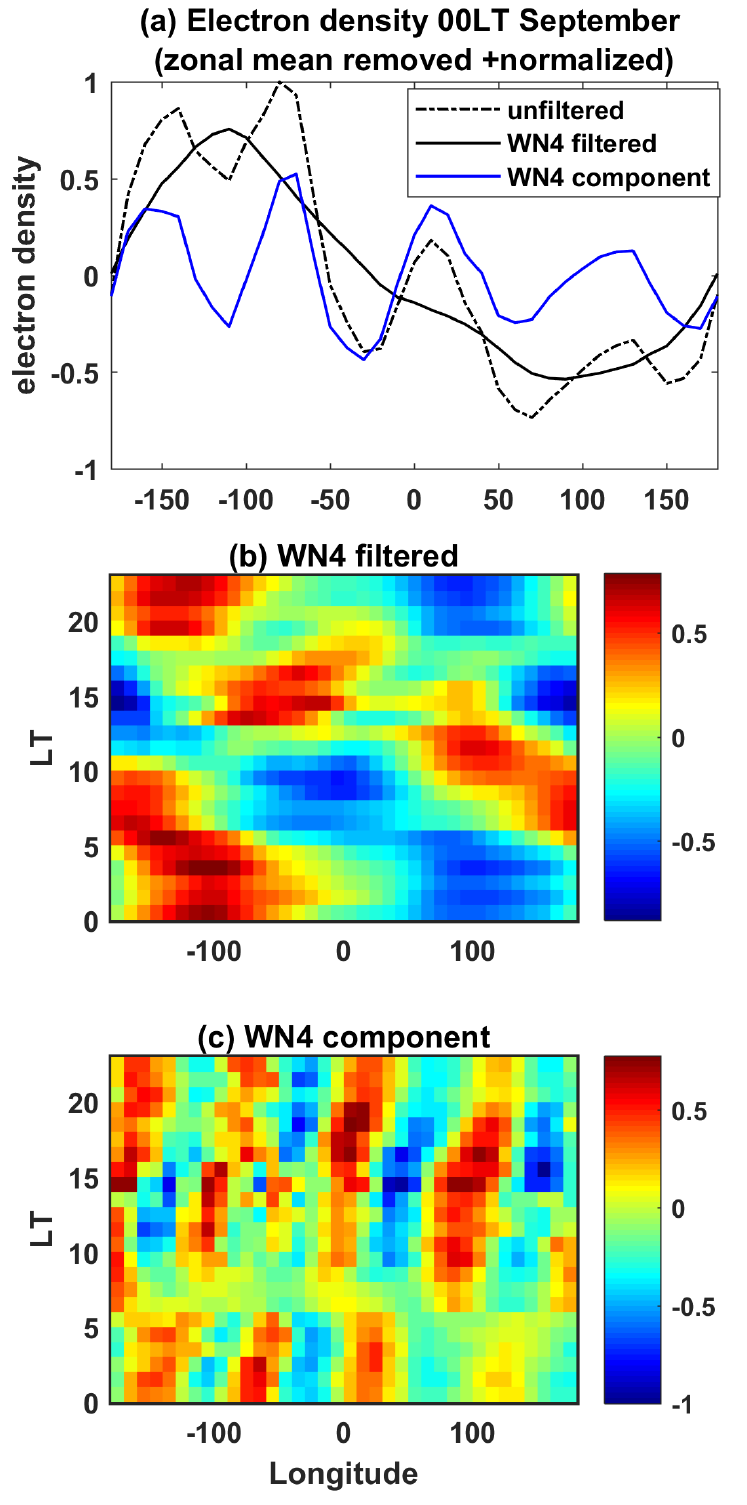
Figure 3. DC-removed + normalized electron density at 302.5 km altitude split into WN4-filtered (residual) and WN4 component. Panel ( a ) presents unfiltered, WN4-filtered, and WN4 components at 00 LT in September 2020. Panels ( b , c ) present the local-time variation of the WN4-filtered component and WN4 component, respectively. Note the eastward propagation in the WN4 component which can be generally attributed to DE3 propagation.